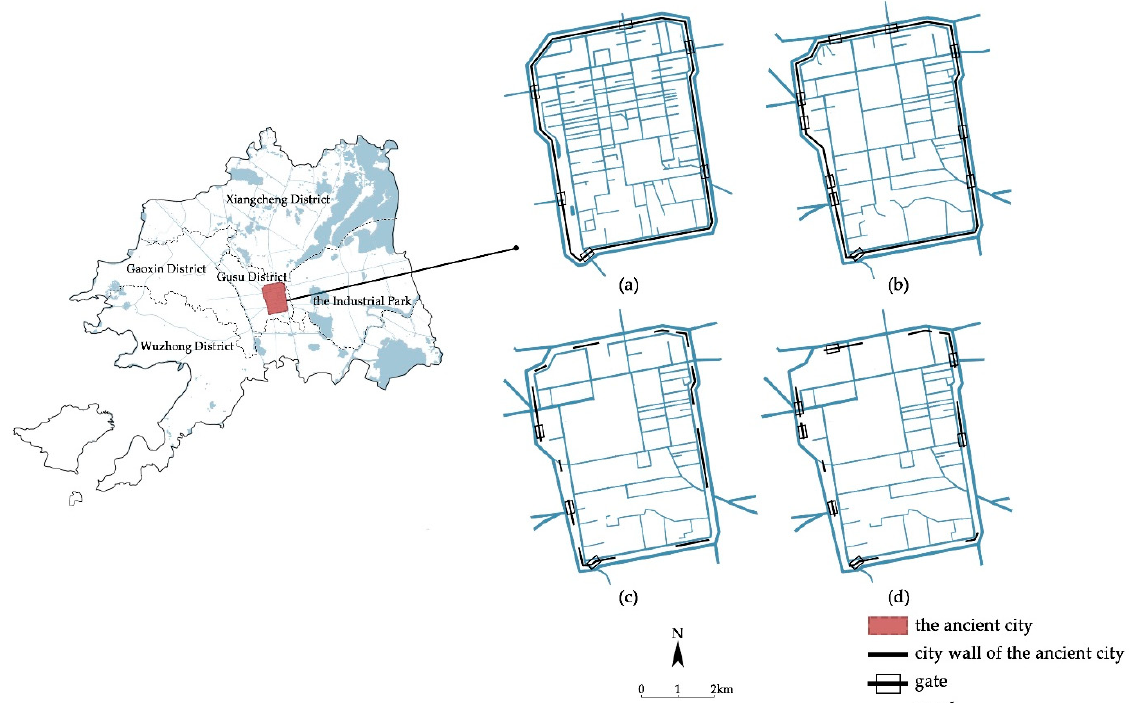
Figure 5. The city walls and pattern of water and streets in Suzhou in Song Dynasty ( a ), Late Qing Dynasty and the Republic of China ( b ), 1985 ( c ), 2020 ( d ).